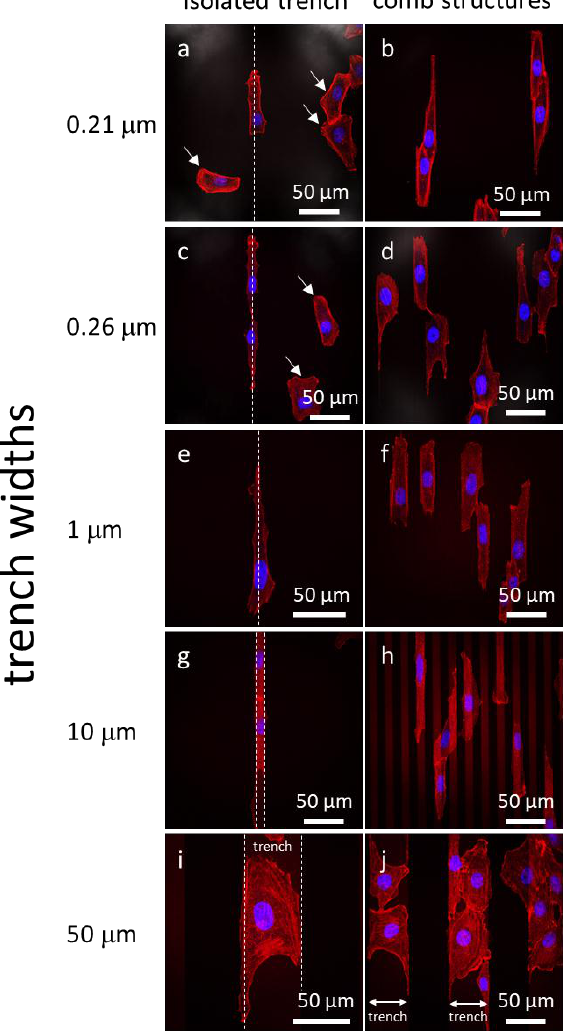
Figure 3. Fluorescence confocal micrographs of adherent cells on isolated trenches (a, c, e, g, i) and comb structures (b, d, f, h, j) with varying trench widths. White dash lines on the left column correspond to the isolated trench boundaries. The DNA is in blue (4′,6-diamidino-2-phenylindole (DAPI)) while F-actin microfilaments are in red (CytoPainter F-Actin). Cells adhered on the field silicon oxide are randomly oriented and labeled with arrows. They aligned with the trench axes when adhered on the patterned comb structures. Micrographs of 10 and 50 μm comb structures show cells prefer to adhere on the tantalum surface. Cells were incubated on the comb structures for 24 h.